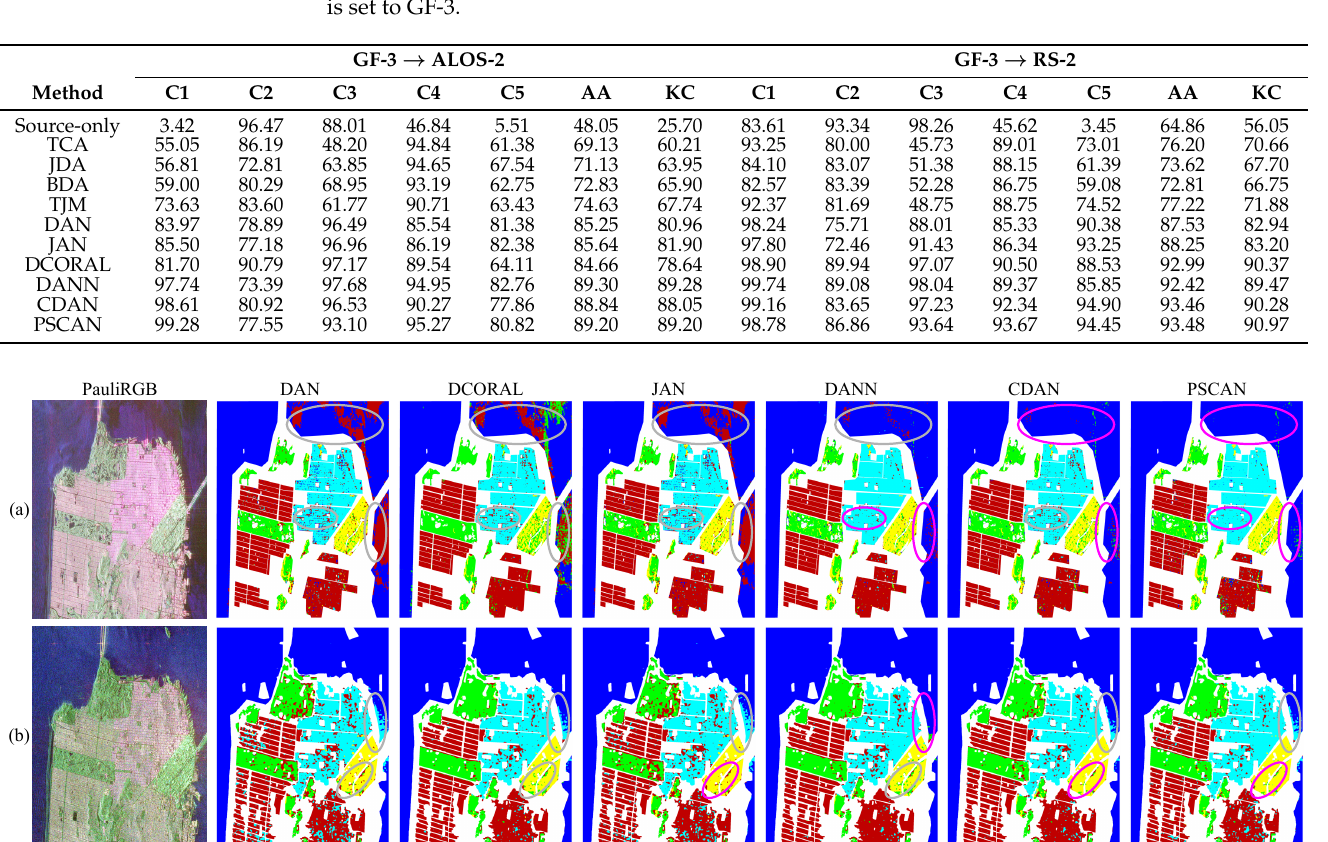
Table 3. Comparison of experimental results (%) on the San Francisco area when the source domain is set to GF-3.